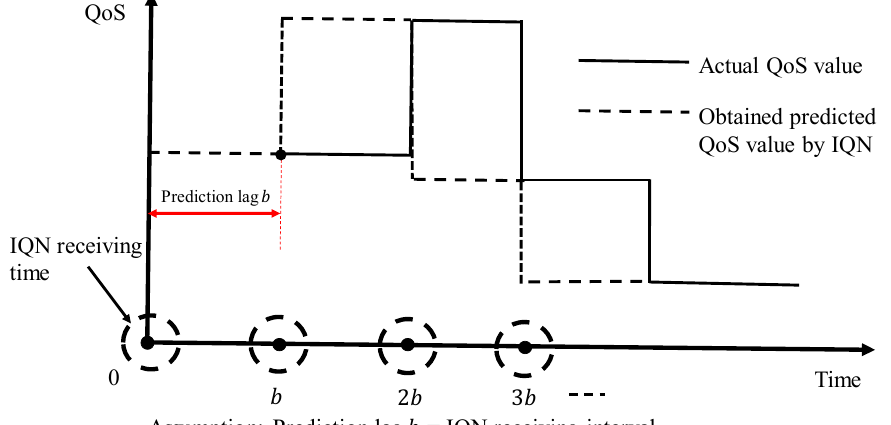
Figure 3. Relationship between received and predicted IQNs.